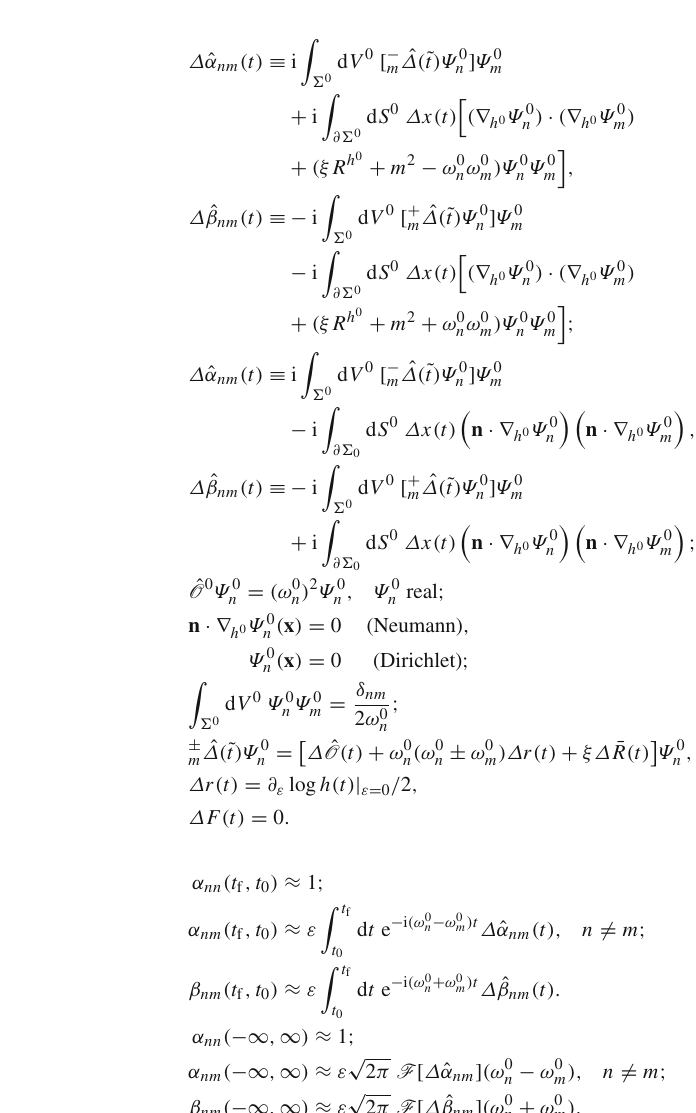
Table 2 Summary of formulae for the application of the method (part 2) Perturbative regime Quantities Δ ˆ α and Δ ˆ